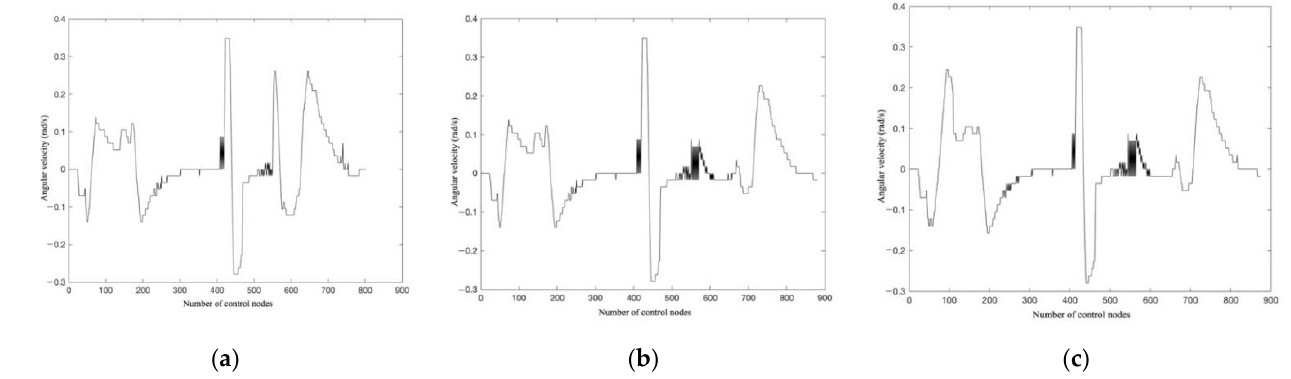
Figure 7. Simulation of changes in the angular velocity of robots: ( a ) Path planning when adding one random obstacle; ( b ) Path planning when adding two random obstacles; ( c ) Path planning when adding three random obstacles.